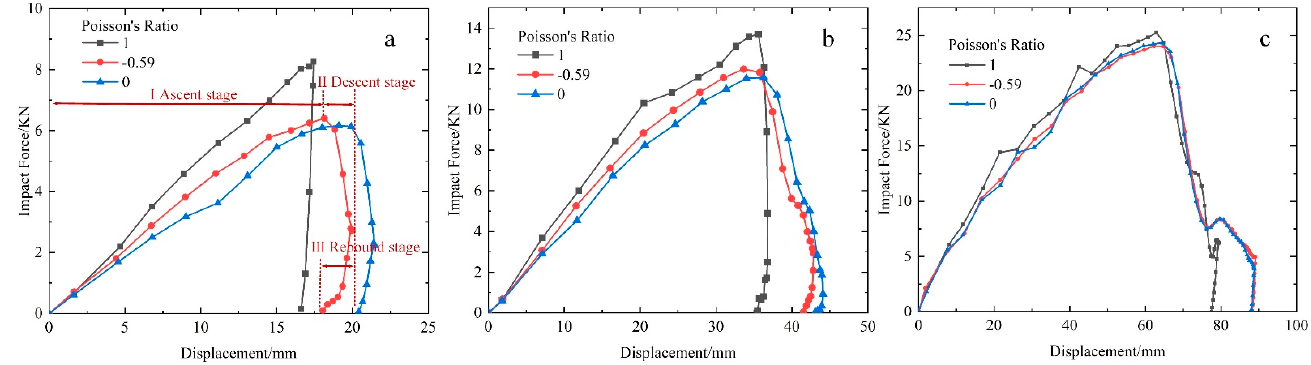
Figure 4. Face sheet impact forces vs. displacement of honeycomb sandwich structures with different Poisson’s ratios: ( a ) 25 m/s; ( b ) 50 m/s; ( c ) 100 m/s.